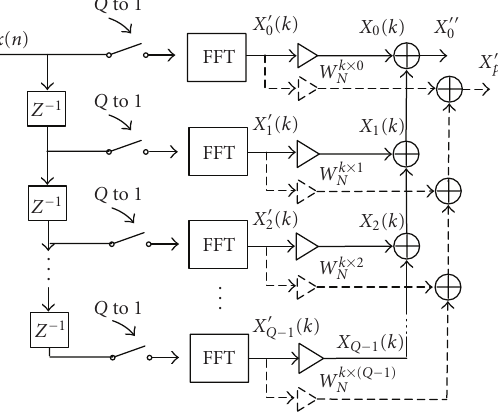
Figure 2: Structure of proposed demodulation